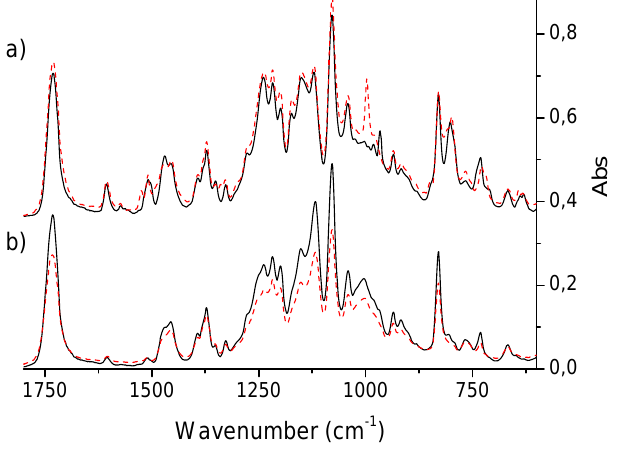
Figure 4 . (a) Infrared absorption spectra of Acetonide-G2-prop-TPPH Acetonide-G2-prop-TPPZn (dashed) molecules. (b) Infrared absorption spectra of Acetonide-G5-prop-TPPH (solid) and Acetonide-G5-prop-TPPZn (dashed) molecules. 2 N.b., the spectra of panel a) was added a constant (0.3) in order to make the plot.